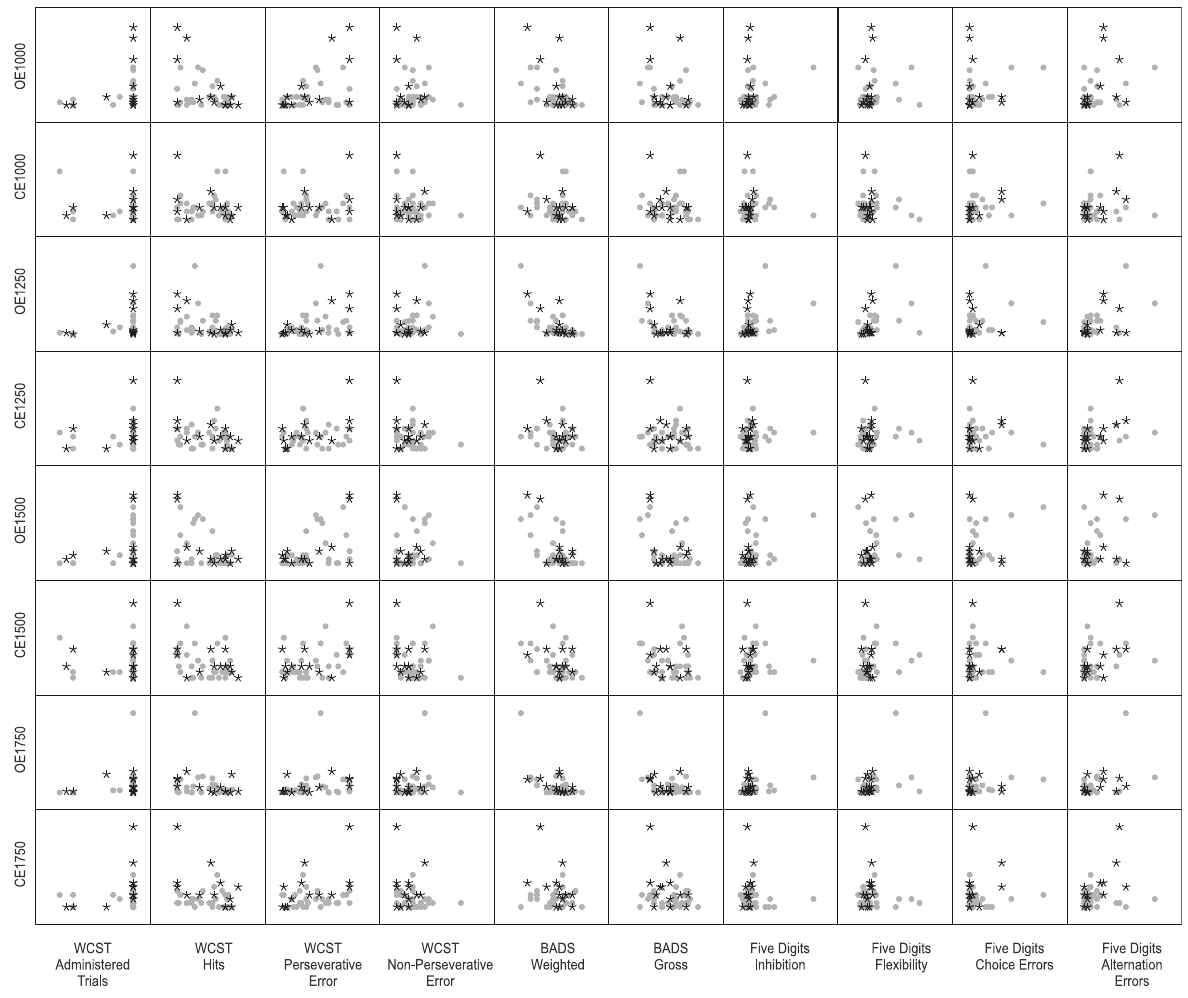
Fig. 2 Correlation matrix among impulsivity and executive functions for both clinical groups (black asterisks=frontal and gray circle=extra-frontal